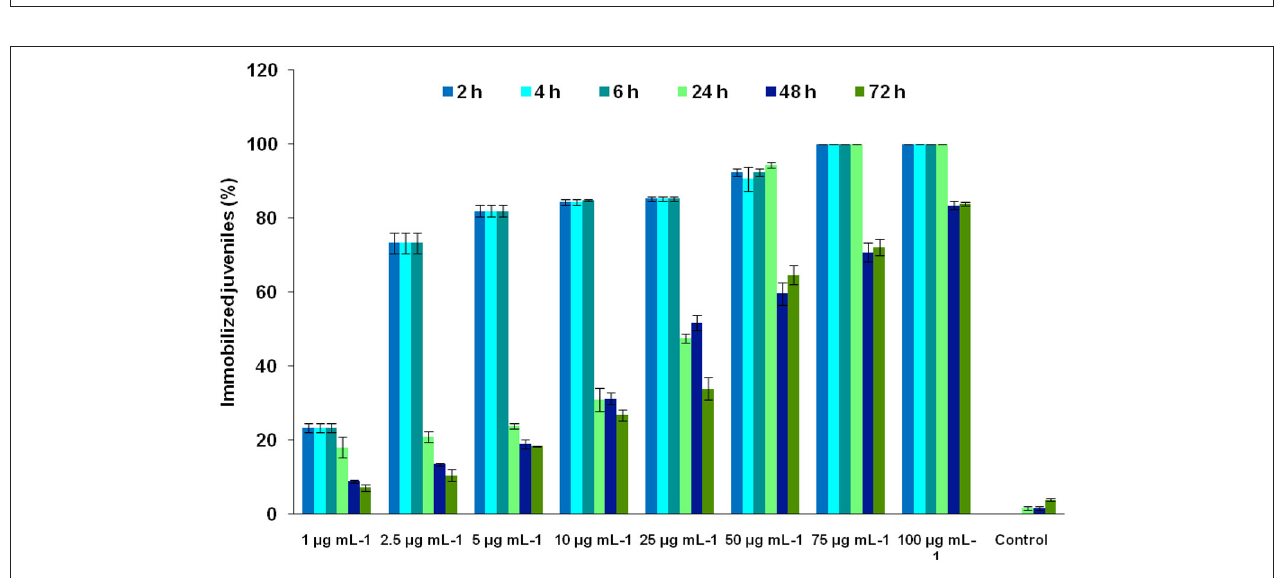
FIGURE 2 | Effect of the concentration of MEO and exposure time on the immobilization of M. incognita J 2 s.